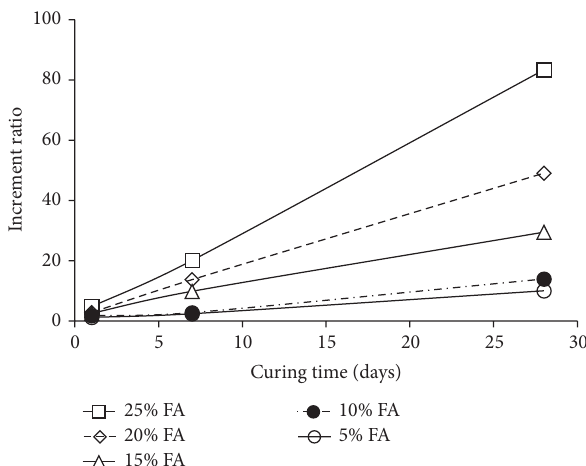
Figure 9: Increase at the CBR values with curing time and FA content.